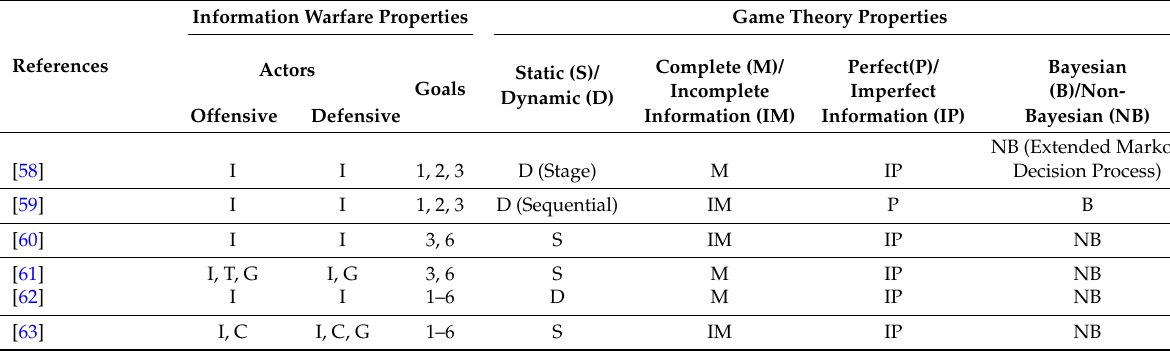
Table 6. List of Electronic Warfare